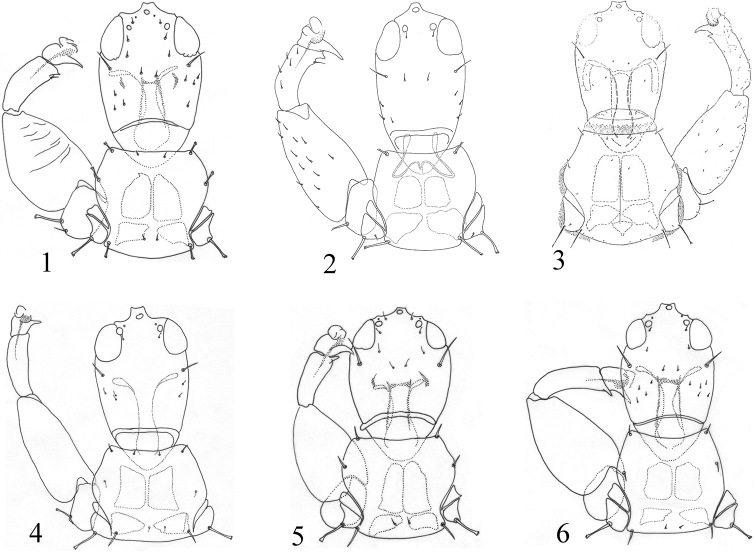
Podothrips species head, pronotum& fore legs 1P.
femoralis sp. nov. 2P.
lucasseni3P.
luteus (from Okajima1978) 4P.
odonaspicola5P.
sasacola6P.
semiflavus.